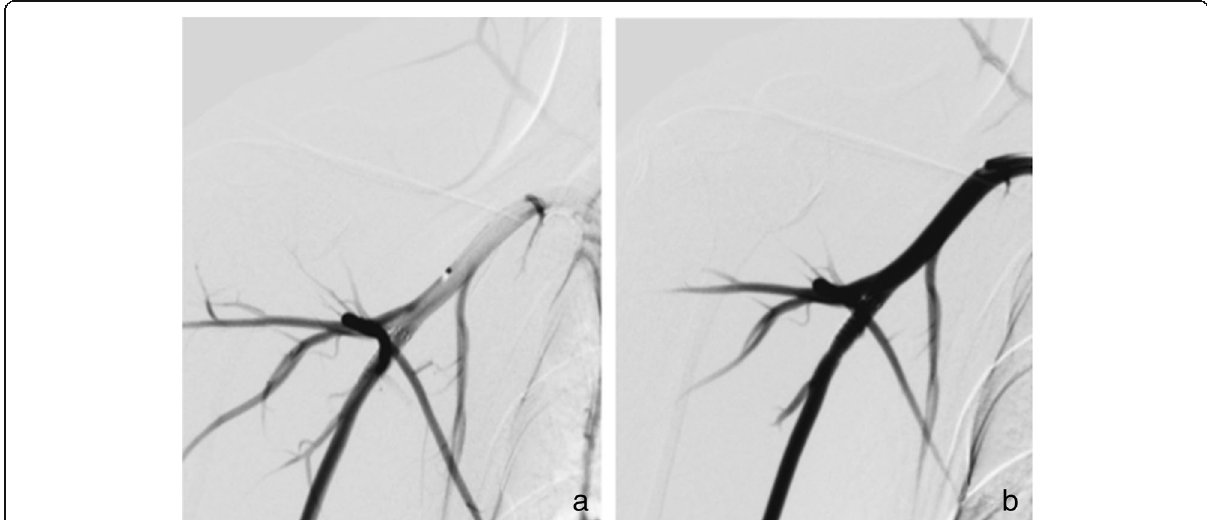
Fig. 3 Subtracted angiographic series of the right subclavian artery of subject number 2 (treated with ASA only), implanted with an HPC-2 coated p64 device. a The FDS immediately after implantation, b 12 min thereafter. After the waiting test, the implant was free from thrombus